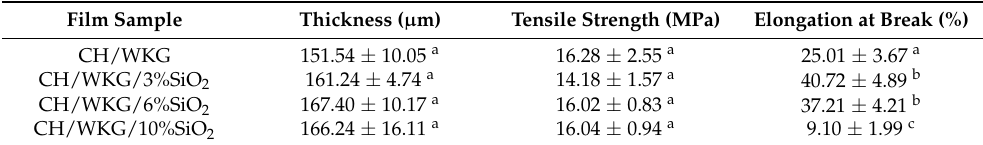
Table 3. Thickness, tensile strength, and elongation at break of the films. The averages of the results followed by the same letter ( a, b ) in the same column do not differ from each other ( p < 0.05). Film